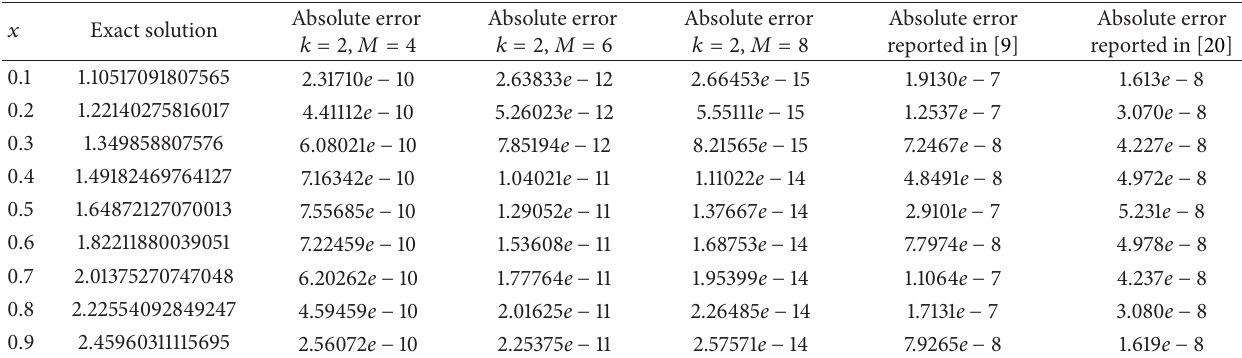
Table 4: Comparison of numerical results for Example 3.